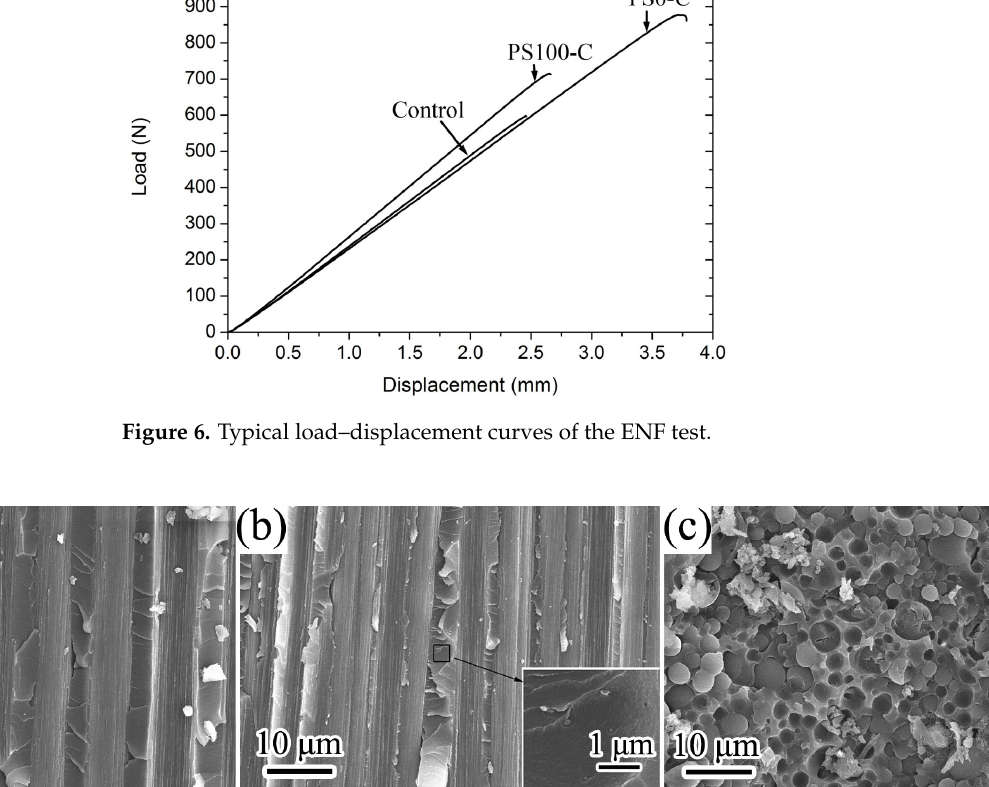
Figure 5. ( a ) Typical load–displacement curves of the DCB test, ( b ) changes of G IC with crack length.